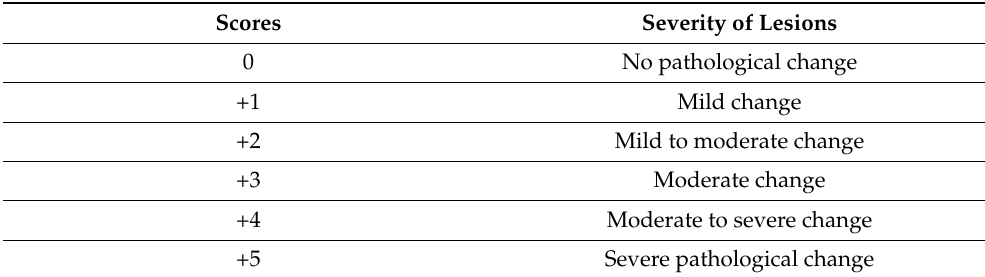
Table 1. The scoring system for each kidney sample.